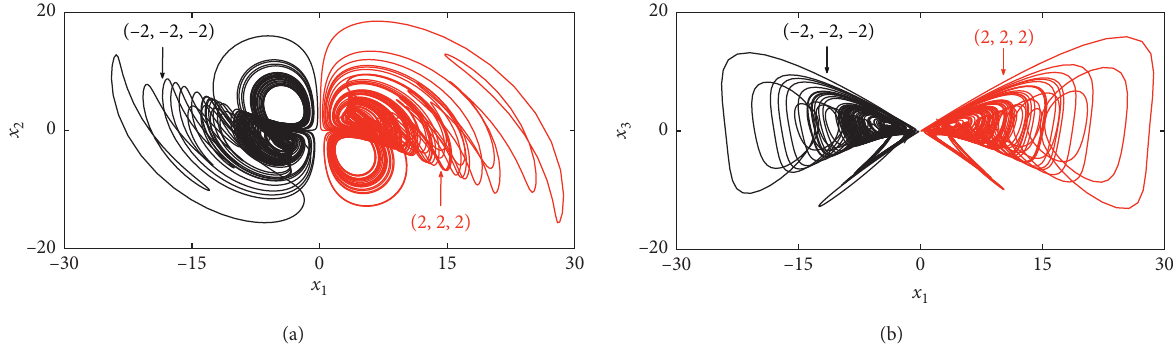
Figure 1: A symmetric pair of coexisting attractors in system (1) with a � 2.5. IC � (2, 2, 2) is red in the positive-x region and IC � ( − 2, − 2, − 2) is black in the negative-x region. (a) The x 1 x 2 phase diagram and (b) the x 1 x 3 phase